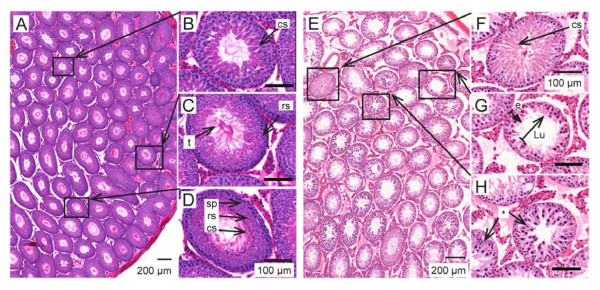
Representative histology of normal or wet-heat-treated testes and seminiferous tubules. A-D: hematoxylin and eosin stained cross-sections of untreated testis. The tall seminiferous epithelium contains many spermatocytes (sp), round spermatids (rs) and condensing spermatids (cs). Tails (t) of condensing spermatids and newly released testicular sperm are seen in the lumen (Lu) of some tubules. E-H: testis cross-section stained two weeks after wet heat treatment. Almost all tubules have enlarged luminal diameters after treatment with heat alone. The seminiferous epithelium (e) is reduced in height due to the loss of many spermatocytes and spermatids. Some tubules have disorganized epithelium (*).